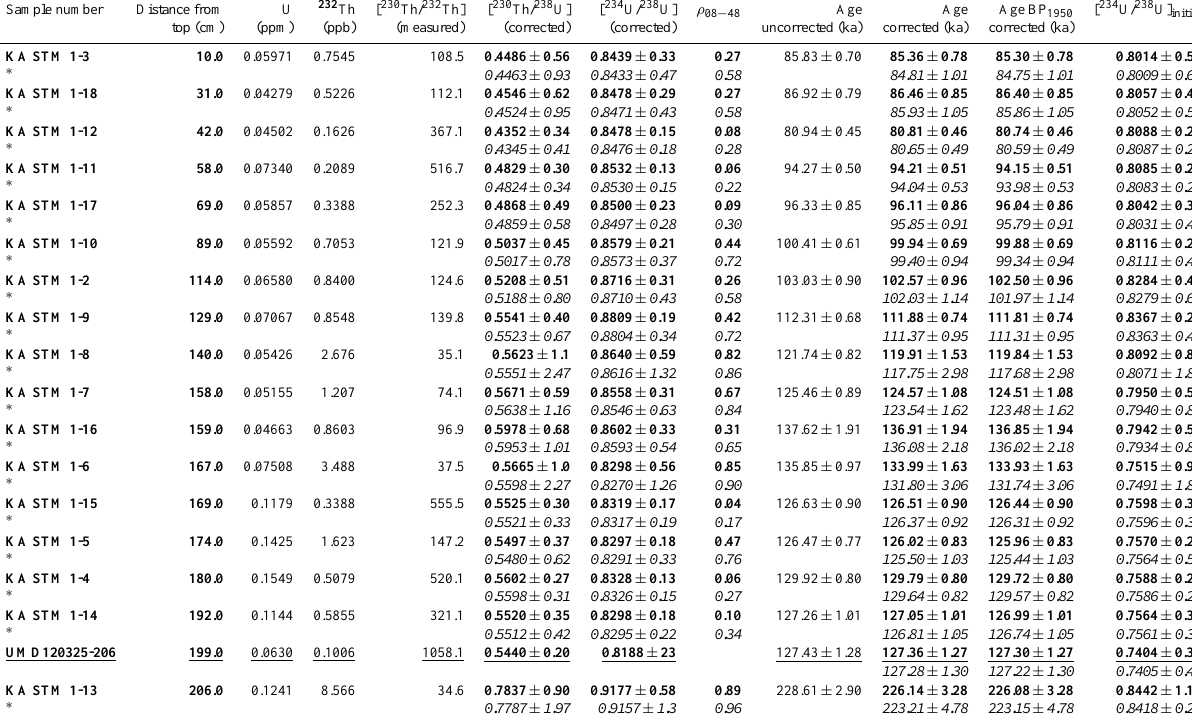
Table 1. U–Th results of K1-2010 dating. Sample